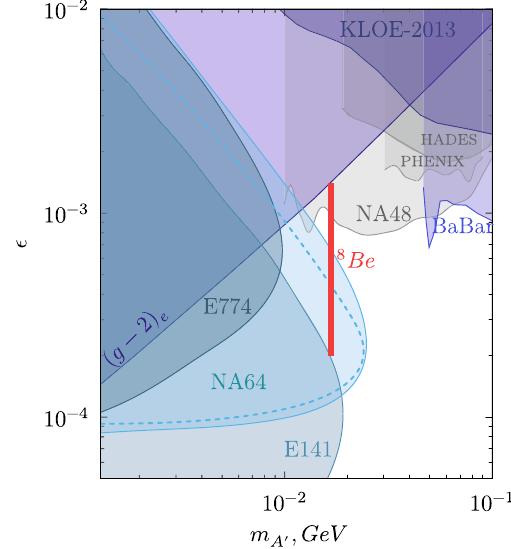
Fig. 1 The blue area shows the NA64 experiment exclusion areas at 90% CL in the ( m A (cid:4) / m X ; (cid:2) ) plane (s). For the mass of 16.7 MeV, the X − e − coupling region excluded by NA64 is 1 . 2 × 10 − 4 < (cid:2) e < 6 . 8 × 10 − 4 . The vertical red bar shows the full allowed range of (cid:2) e explaining the 8 Be* anomaly, 2 . 0 × 10 − 4 (cid:2) (cid:2) e (cid:2) 1 . 4 × 10 − 3 from [1]